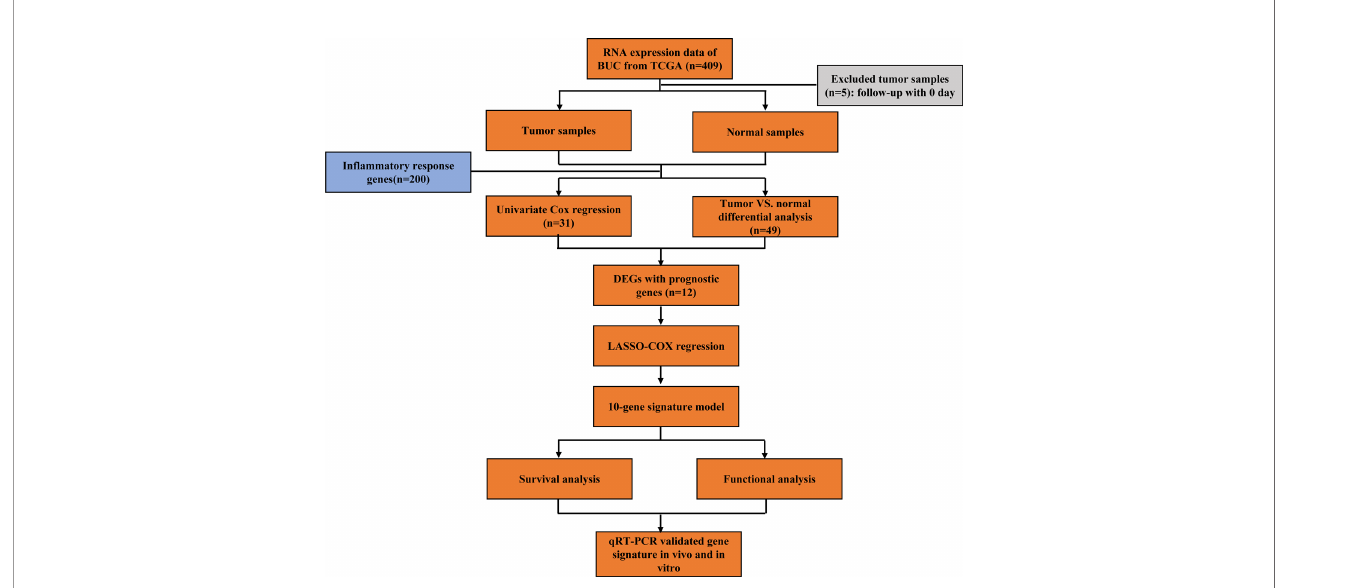
FIGURE 1 | Flow chart of data collection, analysis, and